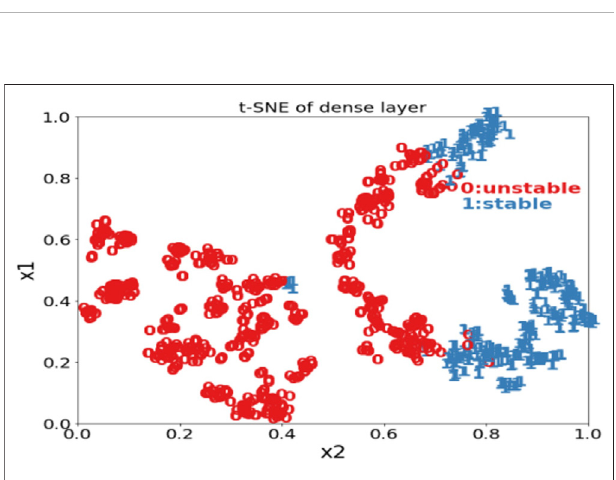
FIGURE 13 | Dense